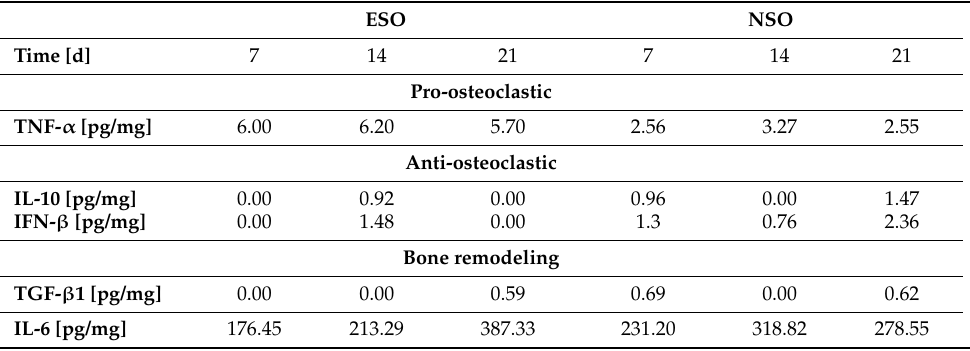
Table 2. Protein concentration of the pooled supernatants of electrically stimulated osteoblasts (ESO) and non-stimulated osteoblasts (NSO) after 7, 14, and 21